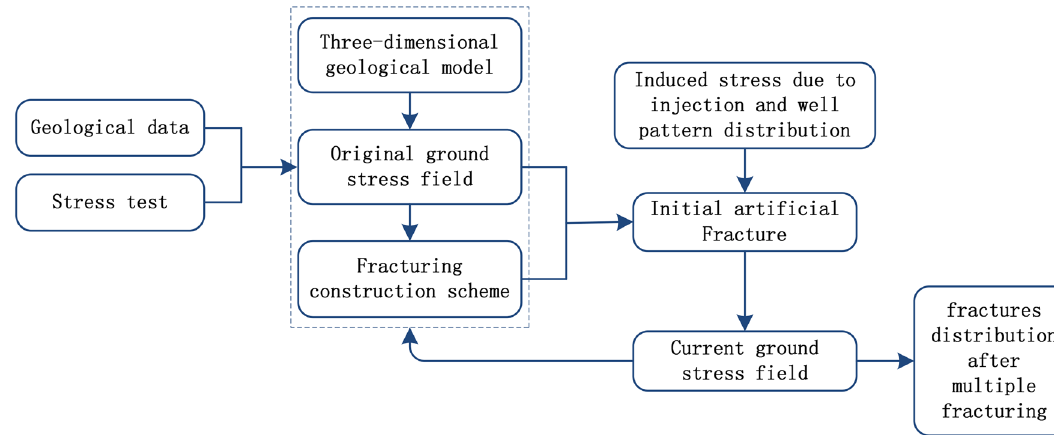
Fig. 4 Artificial fractures prediction